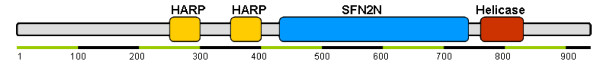
SMARCAL1 has 4 distinctive domains. The starting and ending residue numbers are 245–299, 342–396, 437–727, and 741–818.